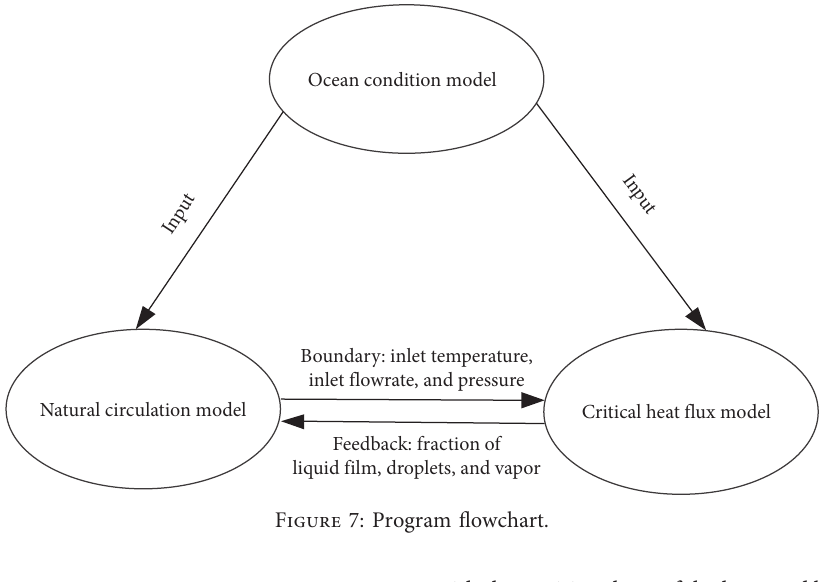
Figure 7: Program flowchart.